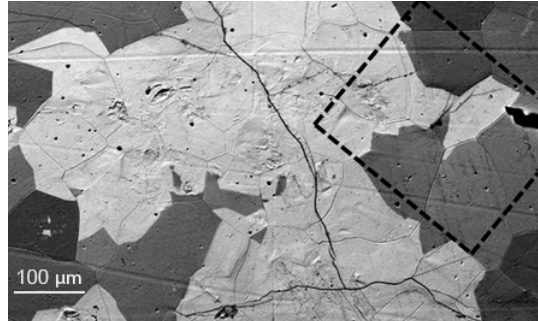
Figure 1. Scanning electron microscope (SEM) image in Backscattered electron shadow (BES) mode of the sample surface where the σ-phase is clearly visible (white) with the α-phase (grey). The dashed line delimits the scanned area during micro X-ray diffraction (XRD) measurements.